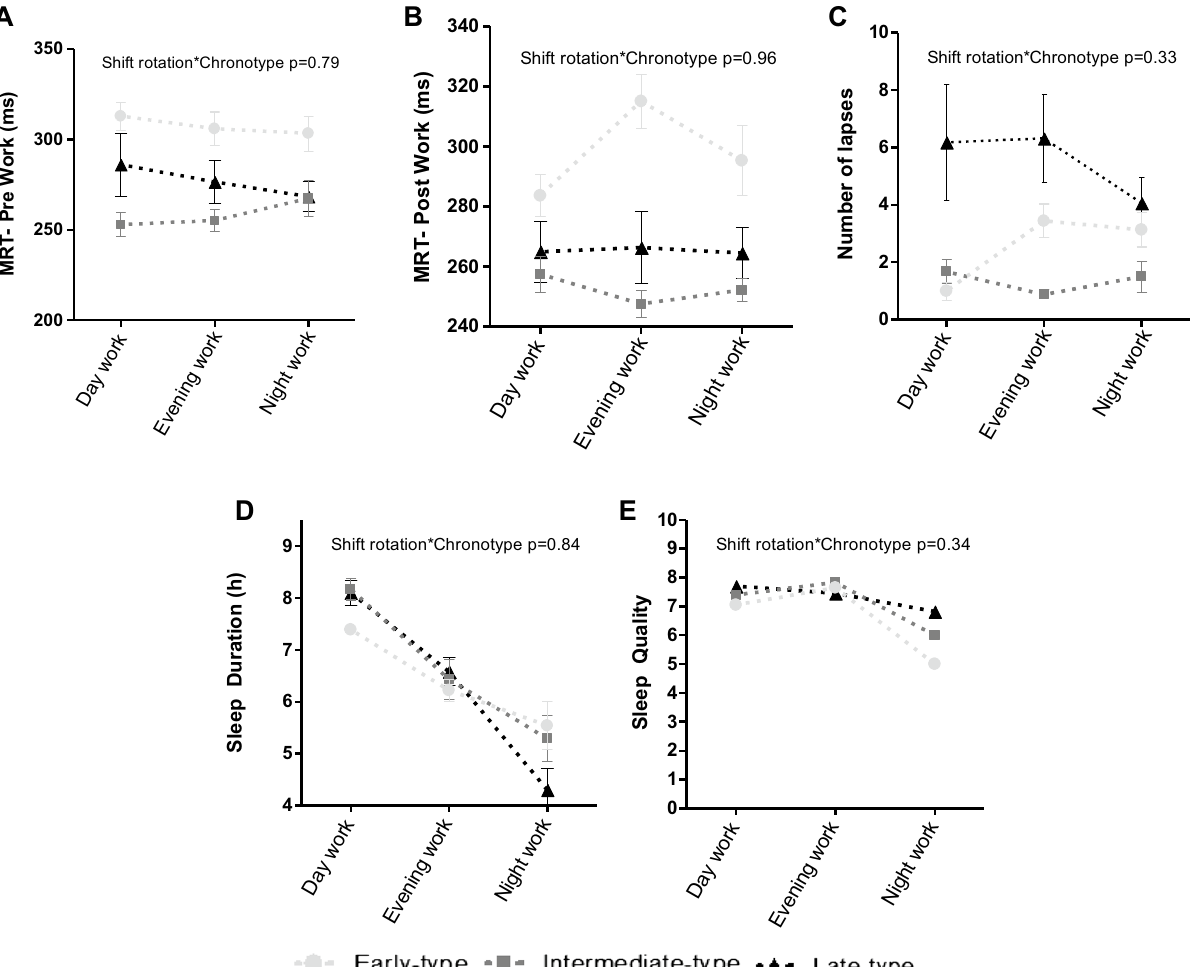
Figure 4. ( A ) Interaction between chronotype and shift rotation on MRT on pre-work. ( B ) Interaction between chronotype and shift rotation on MRT on post-work. ( C ) Interaction between chronotype and shift rotation on sum of lapses during the shift. ( D ) Interaction between chronotype and shift rotation on sleep duration. ( E ) Interaction between chronotype and shift rotation on sleep quality. Data expressed by mean ± standard error of the mean ( n = 30). GLM adjusted for age, BMI, years working in shifts and presence of children at